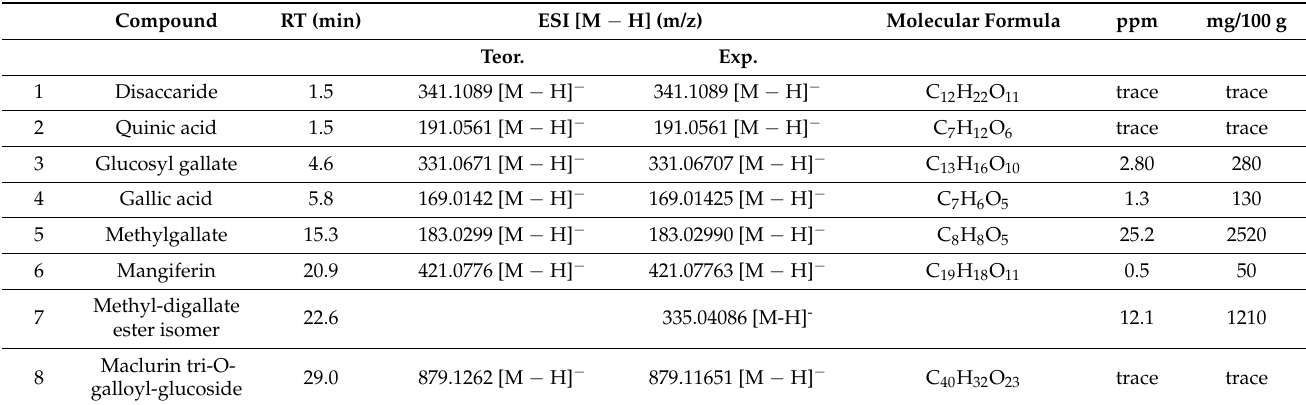
Table 1. Composition of mango seed extract (MSE) HPLC-ESI-MS analysis of Mango seed extracts (MSE) evidenced the presence of 8 polar compounds in MSE. Quantification of mangiferin and gallic acid was performed with the calibration curves of their own